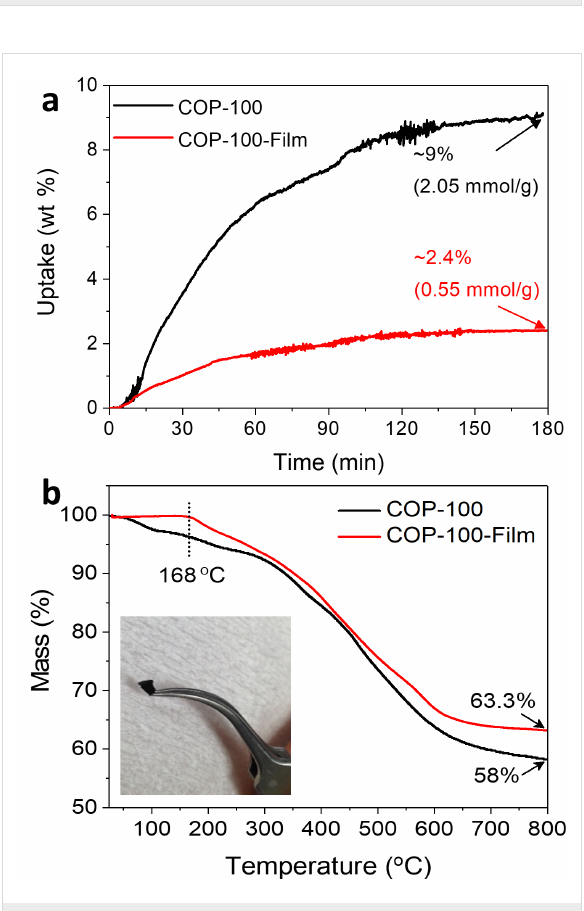
Figure 6: (a) Gravimetric CO 2 adsorption isotherm of COP-100 and COP-100-Film at 40 °C. (b) Thermogravimetric analysis of COP-100 and COP-100-Film under N 2 atmosphere. Inset displays a photograph of the carbonized COP-100-Film.